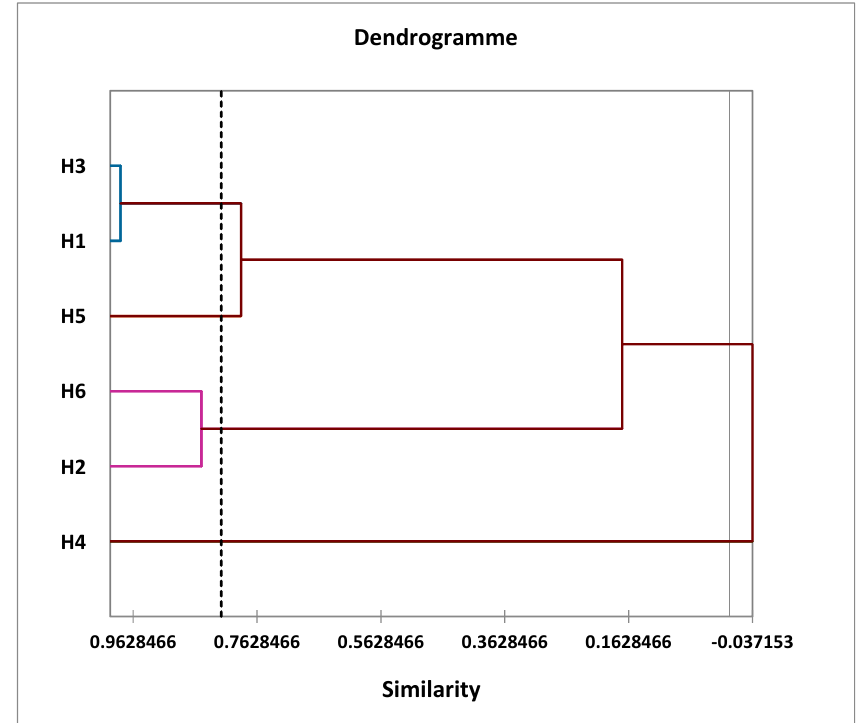
Figure 4. Dendrogram obtained by a hierarchical bottom-up analysis (HCA) of the six samples studied.